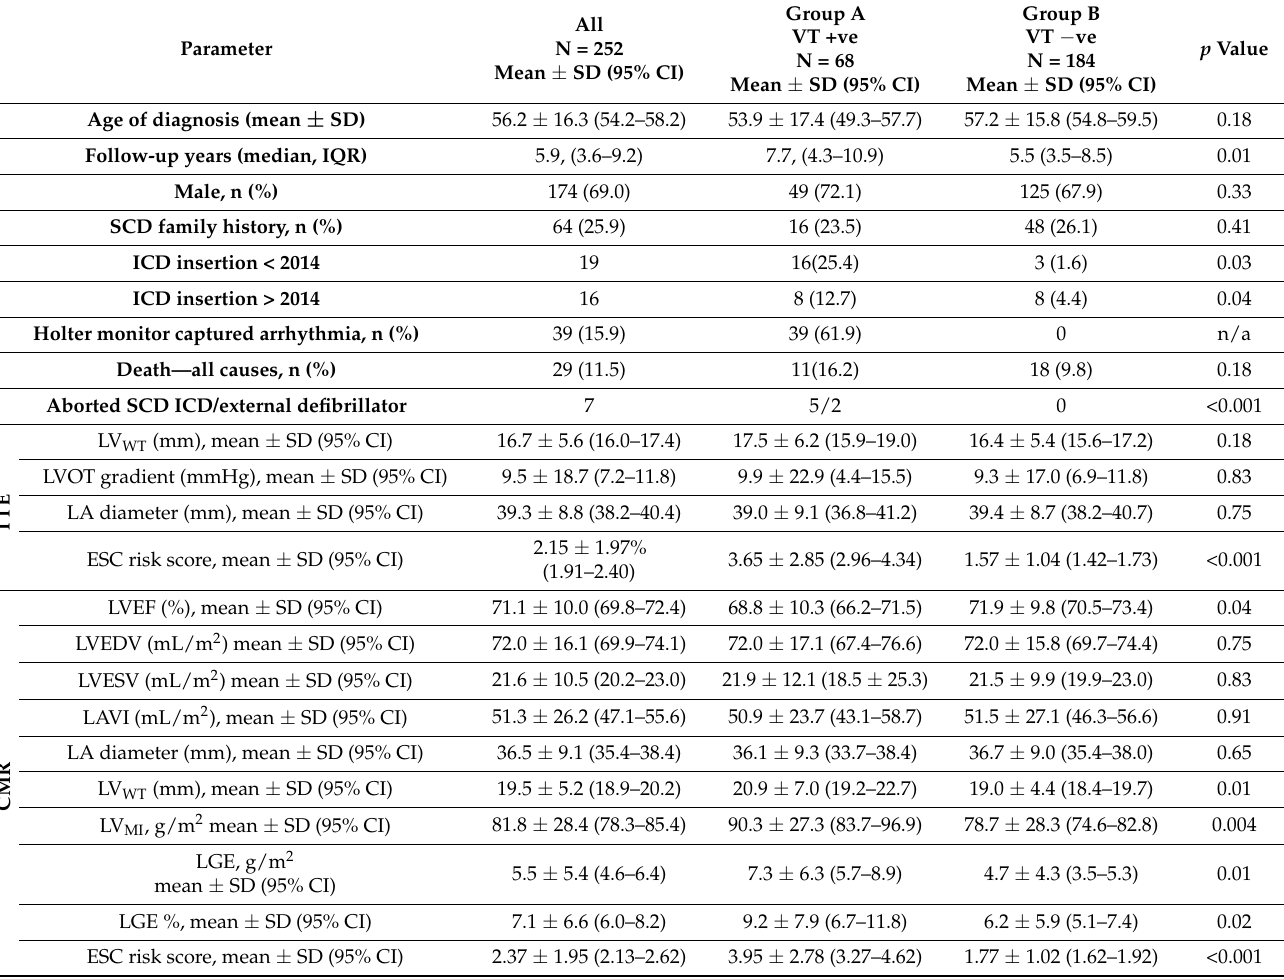
Table 1. Demographics of patients with hypertrophic cardiomyopathy confirmed by